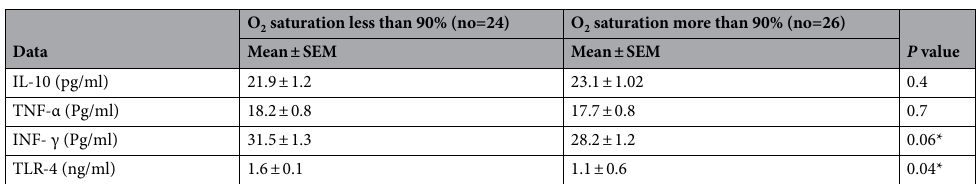
Table 5. The mean value ± SEM of the concentration levels of serum IL-10, TNF- α, INF- γ and TLR-4 in relation to